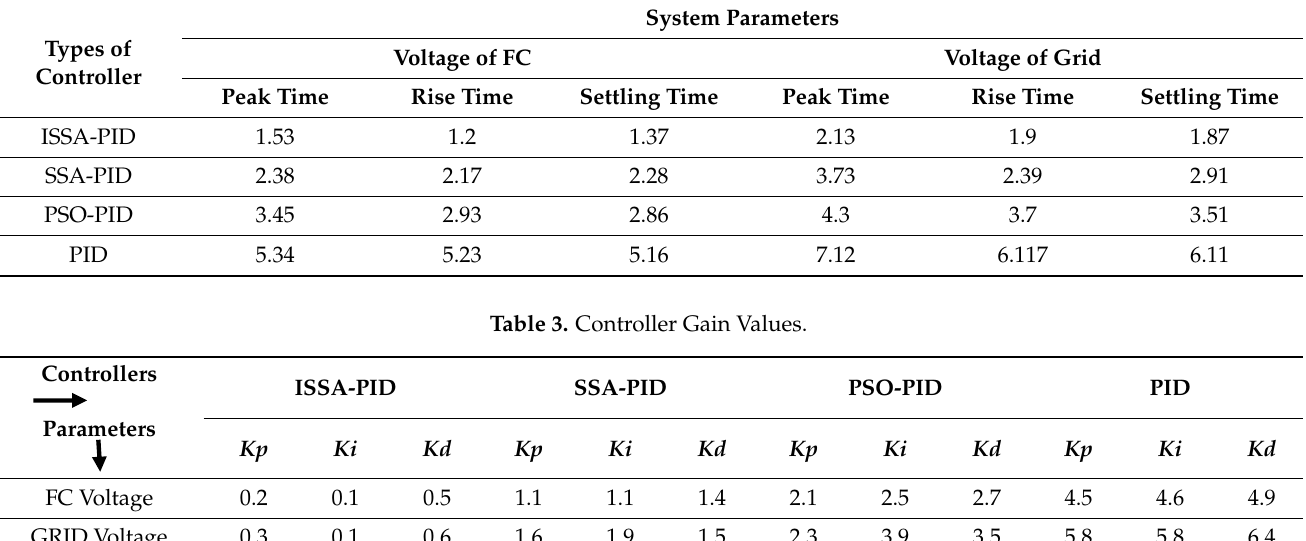
Table 2. System Stability Parameters.